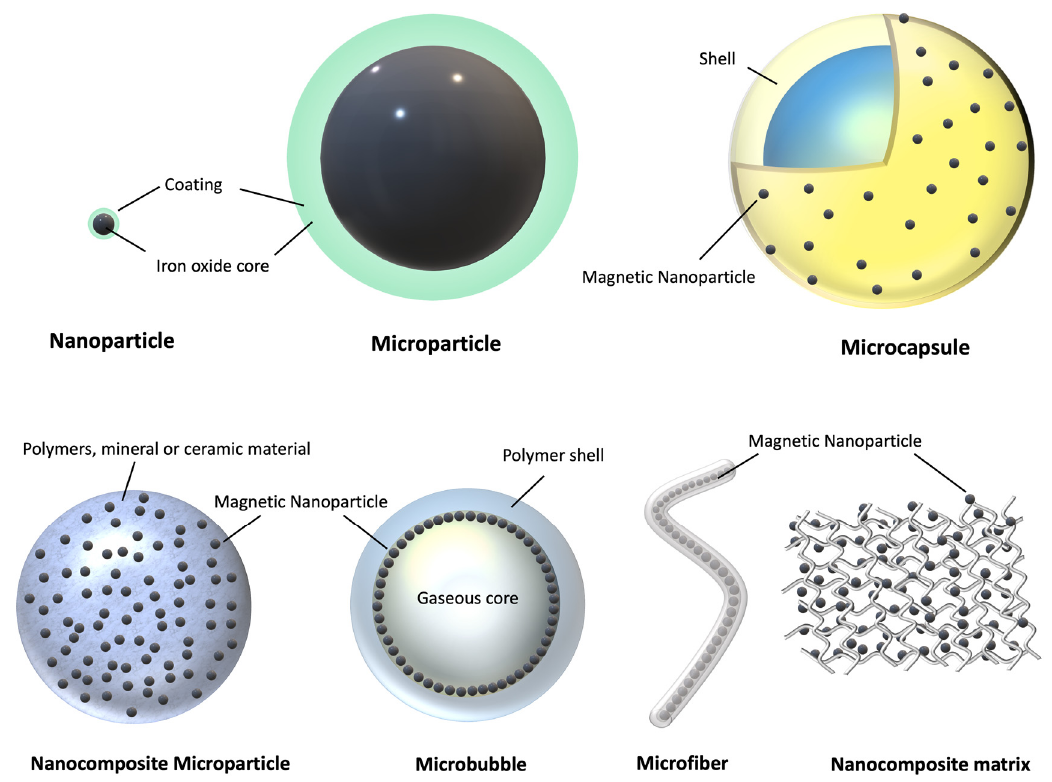
Figure 4. Different morphologies of micro/nanosystems for the magnetic targeted delivery of bi- oagents. Magnetic carriers can be manufactured to have different structural characteristics and clas- sified according to their size and morphological features into: nanoparticles, microparticles, micro- capsules, nanocomposite particles and matrices, microbubbles, and